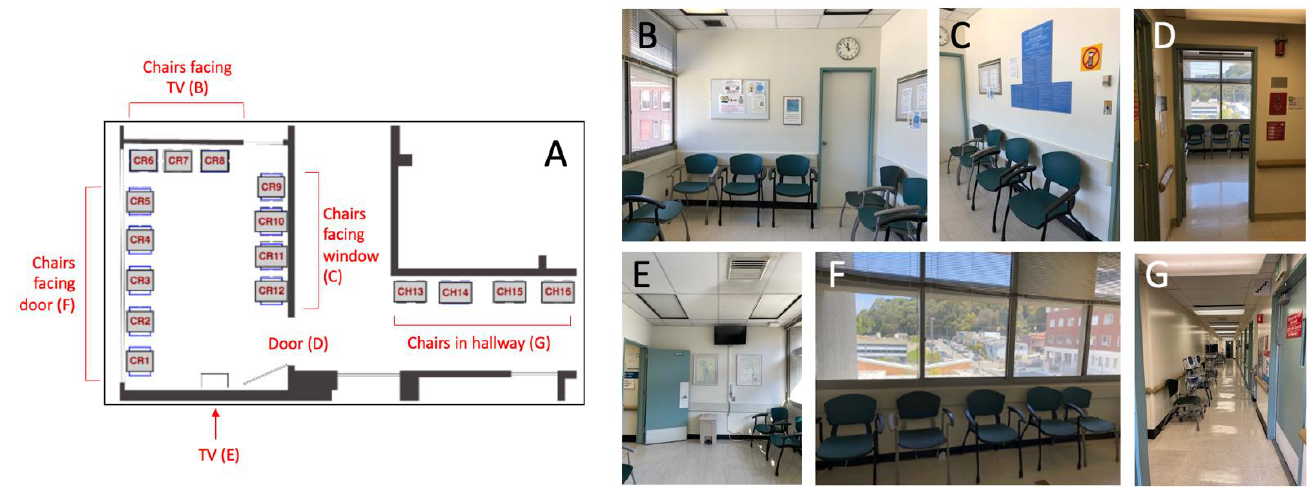
Figure 1. Floorplan of the waiting space with corresponding photos. ( A ) Floorplan labeled with chair types, TV, and door. ( B ) Photo of the chairs facing the TV (chairs 6 – 8). ( C ) Photo of the chairs facing the window (chairs 9 – 12). These chairs line the same wall as the door. ( D ) Photo of entrance of the waiting room from the hallway; ( E ) Photo of wall with TV. ( F ) Photo of the chairs facing the door (chairs 1 – 5). These face the doorway and have their backs to the windows. ( G ) Photo of the chairs in the hallway (chairs 13 – 16).